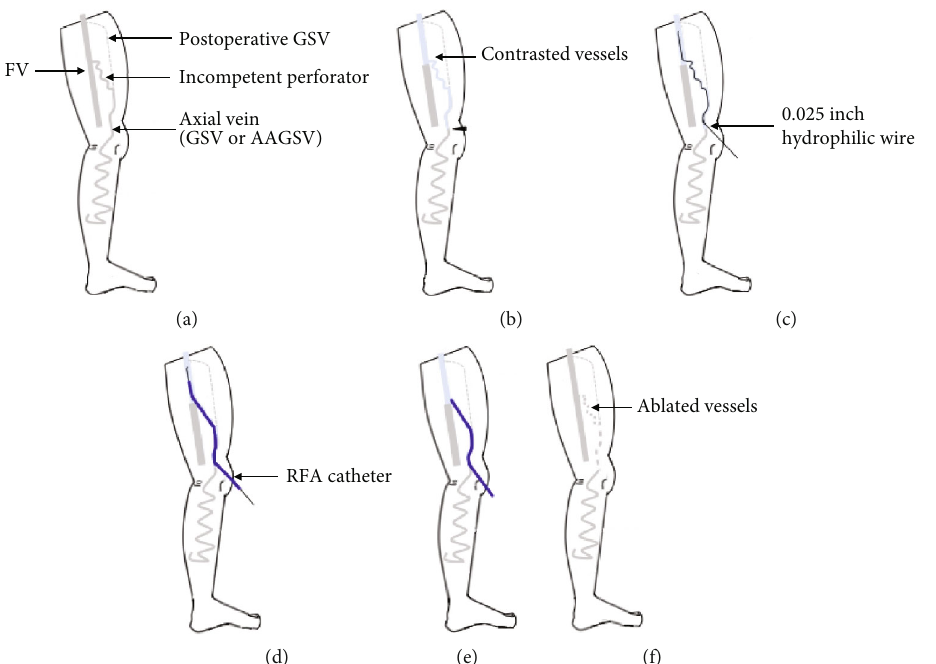
Figure 1: Schemas of venography and selective ablation technique. Recurrent varicose vein after great saphenous vein surgery is caused by incompetent perforator veins (IPVs) (a). Venography is performed using a 7-French sheath at axial vein around the knee (arrowhead) (b). A 0.025-inch hydrophilic wire is crossed to the femoral vein (FV) (c). A radiofrequency ablation (RFA) catheter is advanced over the 0.025-inch wire to the FV (d). The RFA catheter is pulled back to adjust the border between the FV and branch vein while contrasting from the lumen (e). Endovenous thermal ablation is performed from the IPV to the axial vein (f). GSV: great saphenous vein; AAGSV: anterior accessory great saphenous